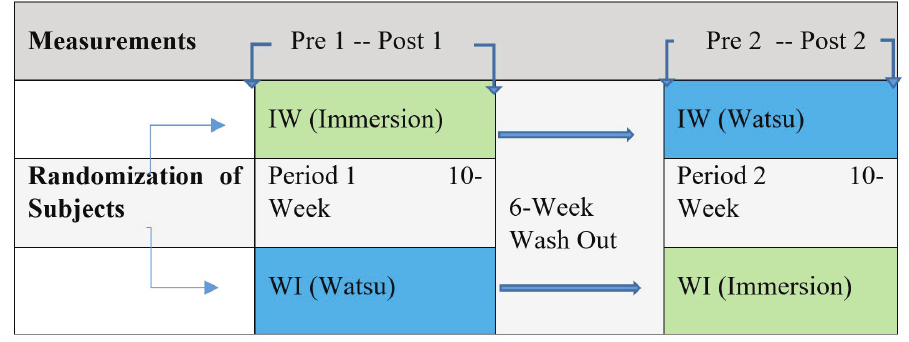
Figure 2. The cross over design for this study